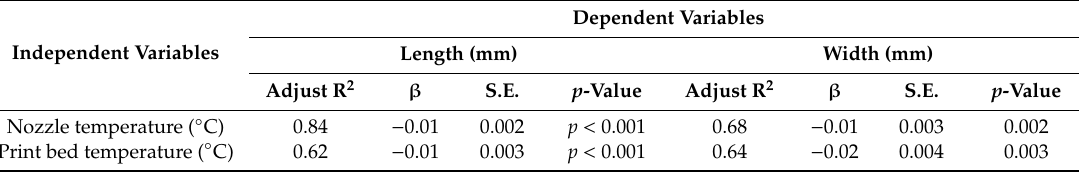
Table 2. Univariate linear regression analysis to predict meniscus length and width using nozzle and print bed temperatures.